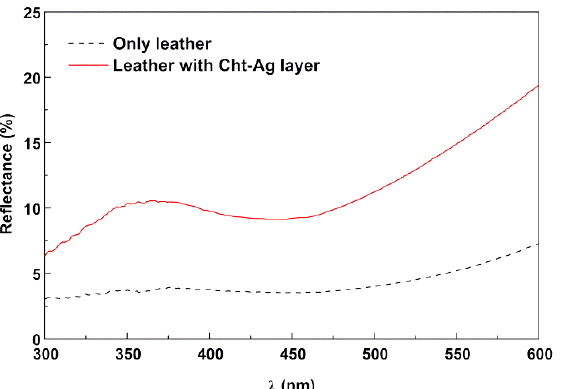
Figure 4. Total reflectance spectra of uncoated leather and leather coated with CSNP dispersion in 2% formic acid solution.